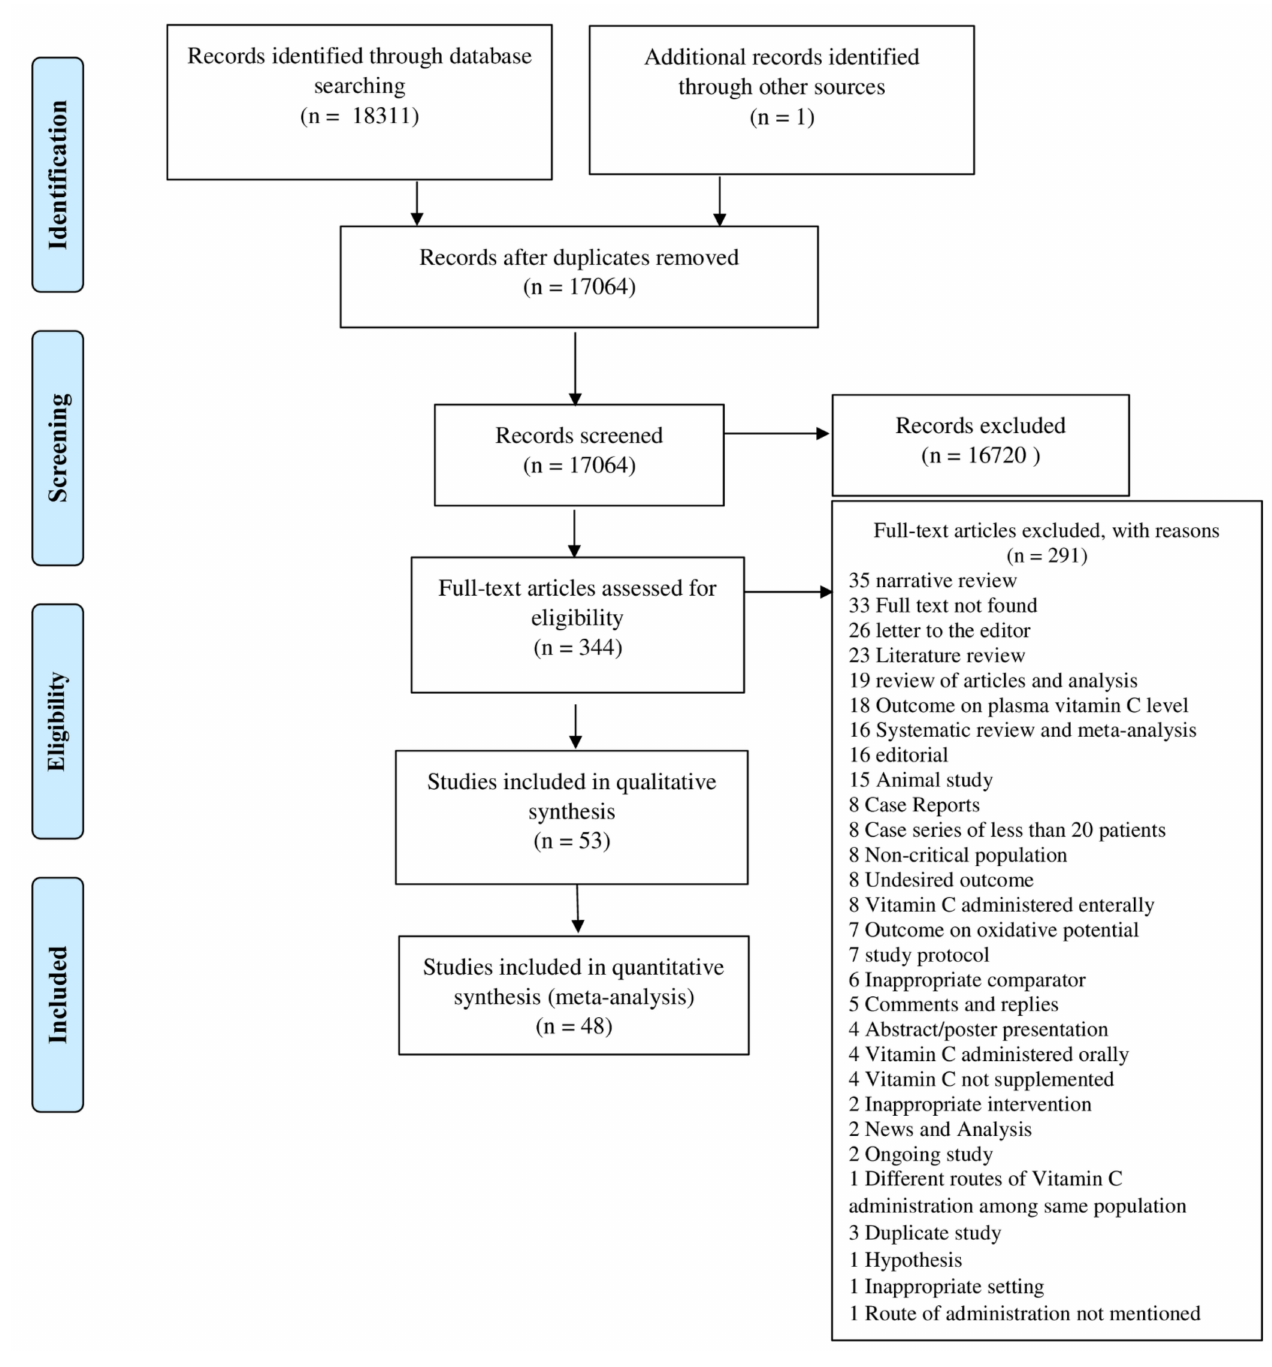
Figure 2. PRISMA Flow